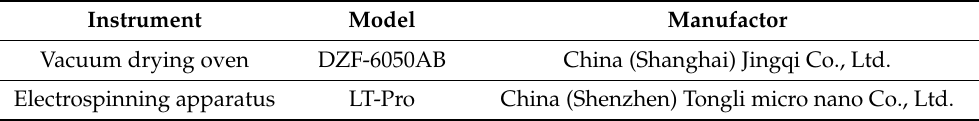
Table 2. The main devices.